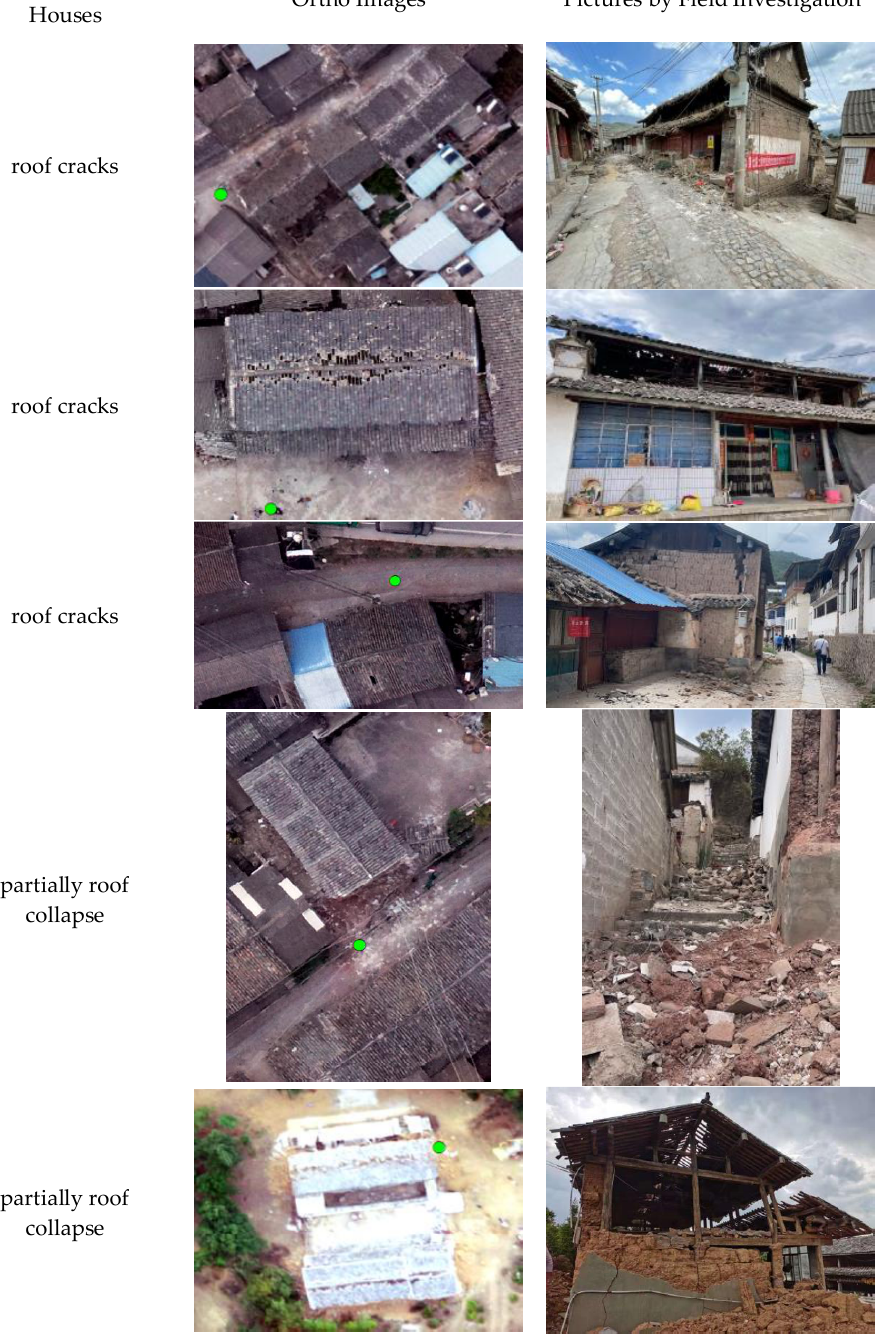
Figure 3. The samples of types of damaged houses. The green dots are the locations of field investi- gation.